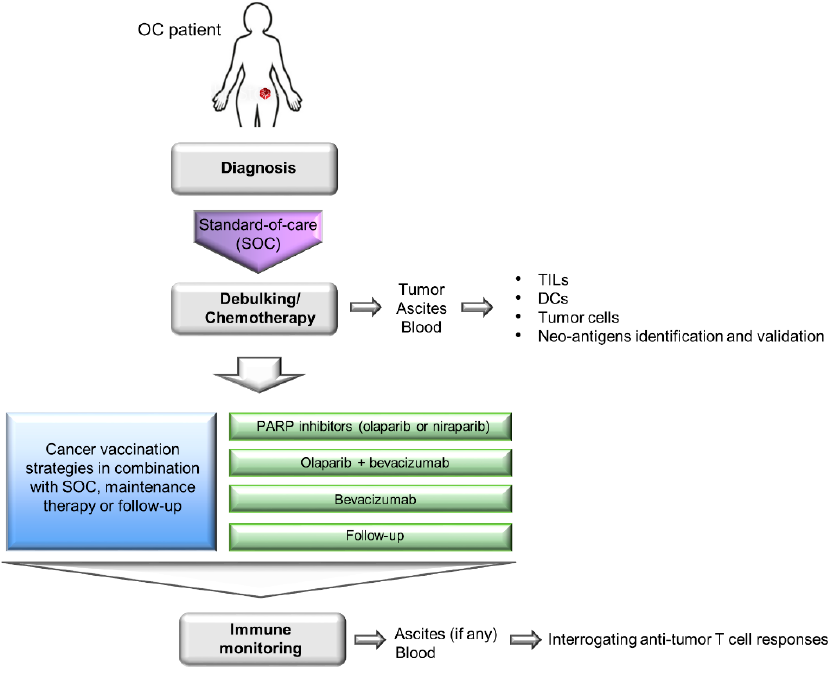
Figure 2. Proposed cancer vaccination strategies in the consolidation setting following standard-of-care chemotherapy and surgery in OC. The preclinical murine ID8 ovarian tumor model can serve as a useful tool to mimic the actual OC clinical scenario described here for evaluating combinatorial OC standard-of-care treatments and cancer vaccination strat- egies. As an example, during the first-line debulking surgery, different clinical samples (i.e., tumors, ascites and blood) can be obtained from the patients for preparing tumor WTL, DC vaccine, identifying and validating tumor (neo)-antigens from TILs and tumor cells. Next, different cancer vaccination strategies as described in Figure 1 can be implemented in combination with the OC standard-of-care, maintenance therapy or follow-up. Finally, additional blood and ascites sam- ples can be obtained from the patients to evaluate their therapeutic anti-tumor T cell responses as well as track their disease